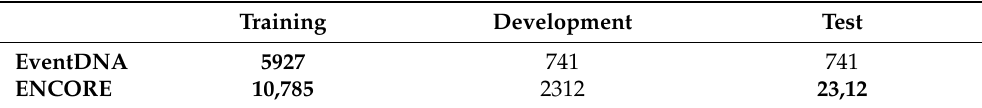
Table 3. Number of events in the train, development and test splits for the EventDNA and ENCORE corpora. Parts of the training set that are actively used for the training and evaluation of the end-to- end setup are highlighted in bold. Training Development Test EventDNA 5927 741 741